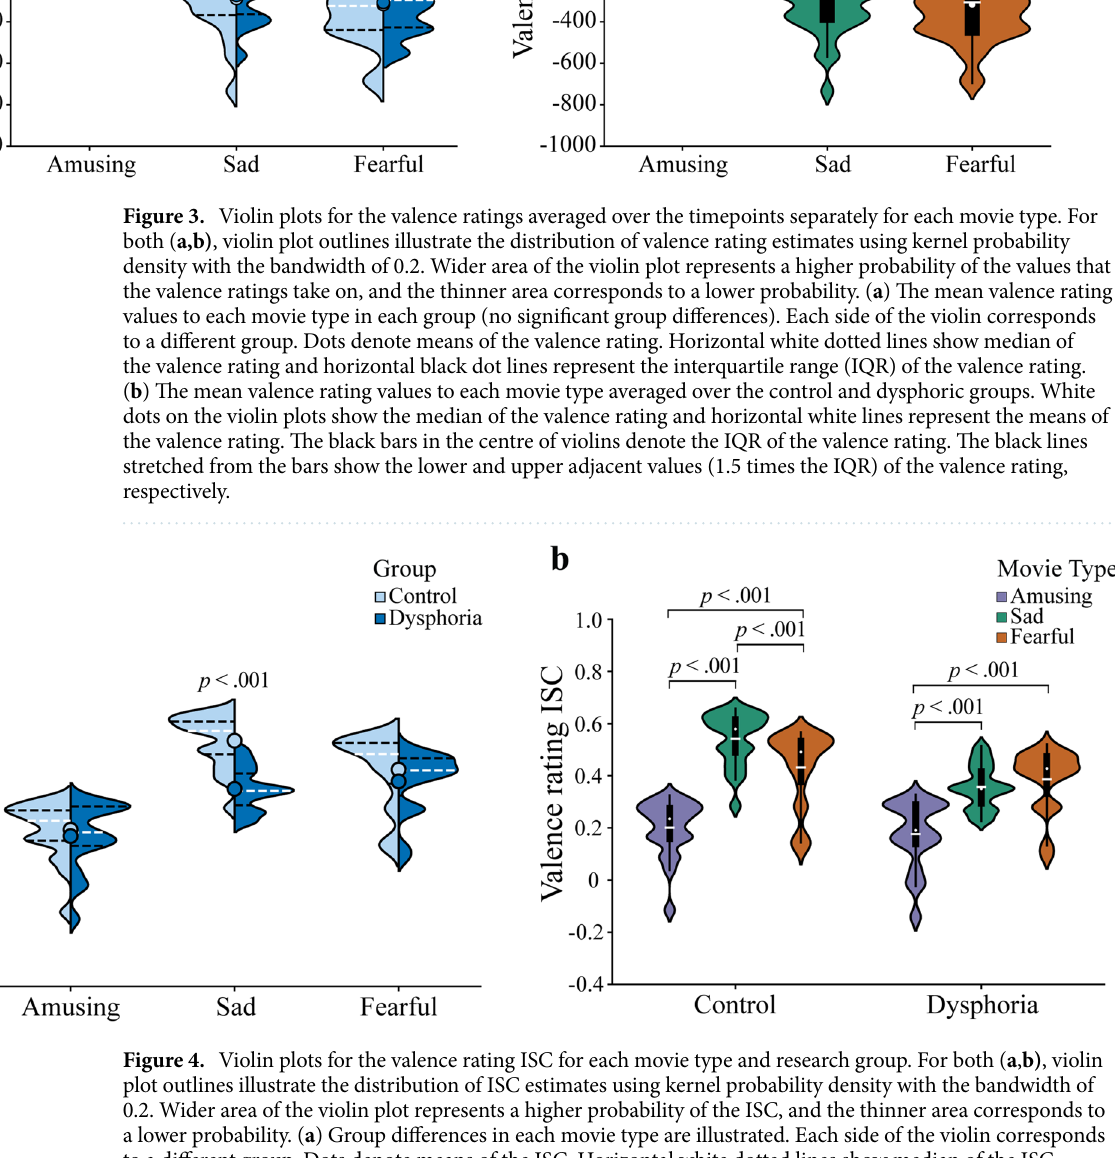
showed no correlations between the valence ratings and number of depressive symptoms for any movie type (all p -values > 0.505, FDR corrected). The correlations between valence rating ISC and BDI-II scores were non-significant for each movie type in the control group (all p -values > 0.955, FDR corrected) and the dysphoric group (all p -values > 0.999, FDR cor- rected). For the whole sample, Spearman’s rank correlation test revealed a negative relationship between valence